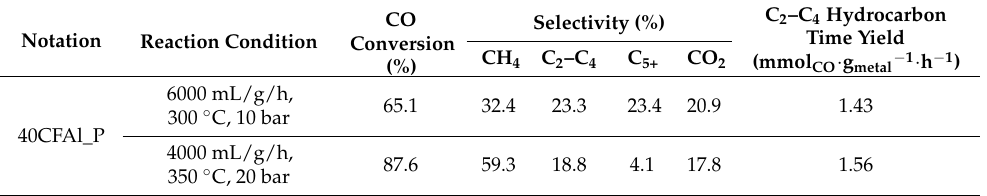
Table 3. Summary of the catalytic performance over the 40CFAl_P catalyst under different